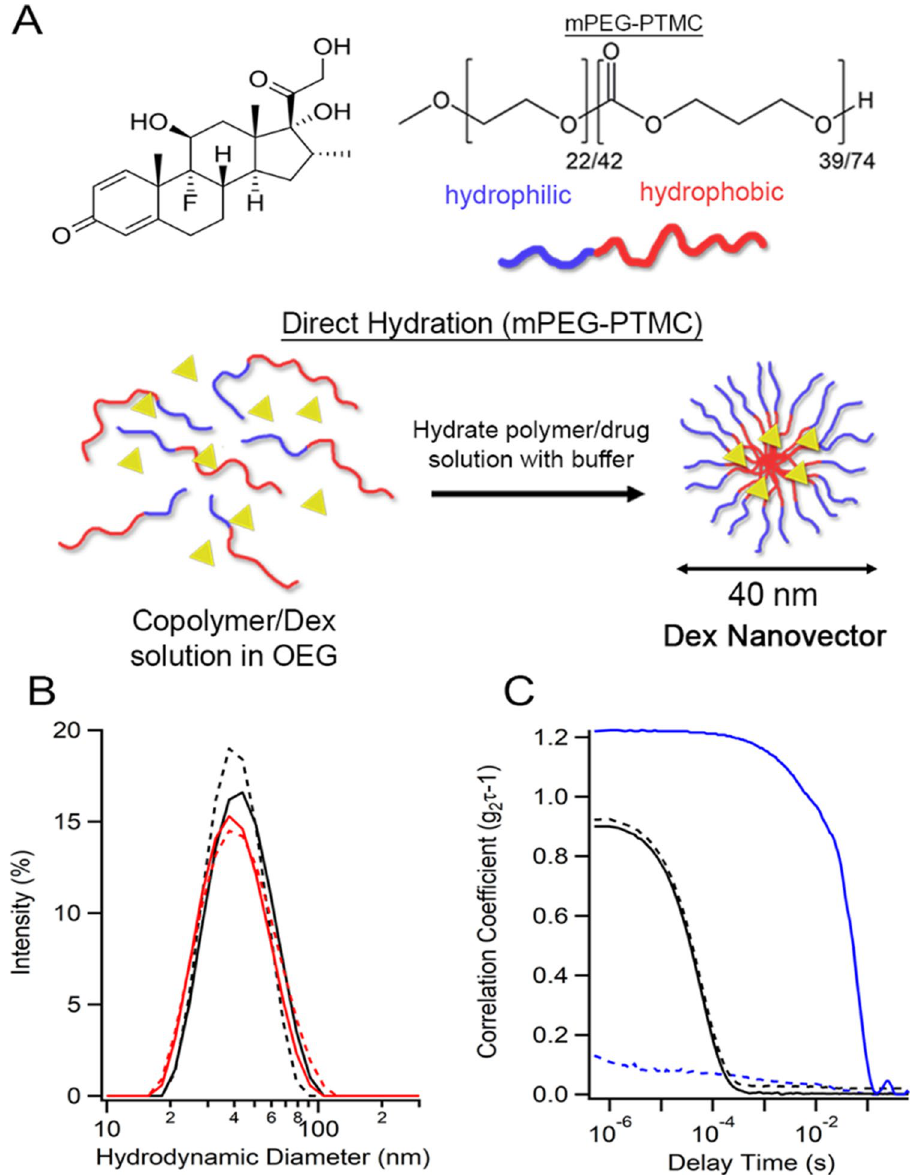
3,3,3 ′ ,3 ′ -tetramethylindotricarbocyanine iodide, DLS dynamic light